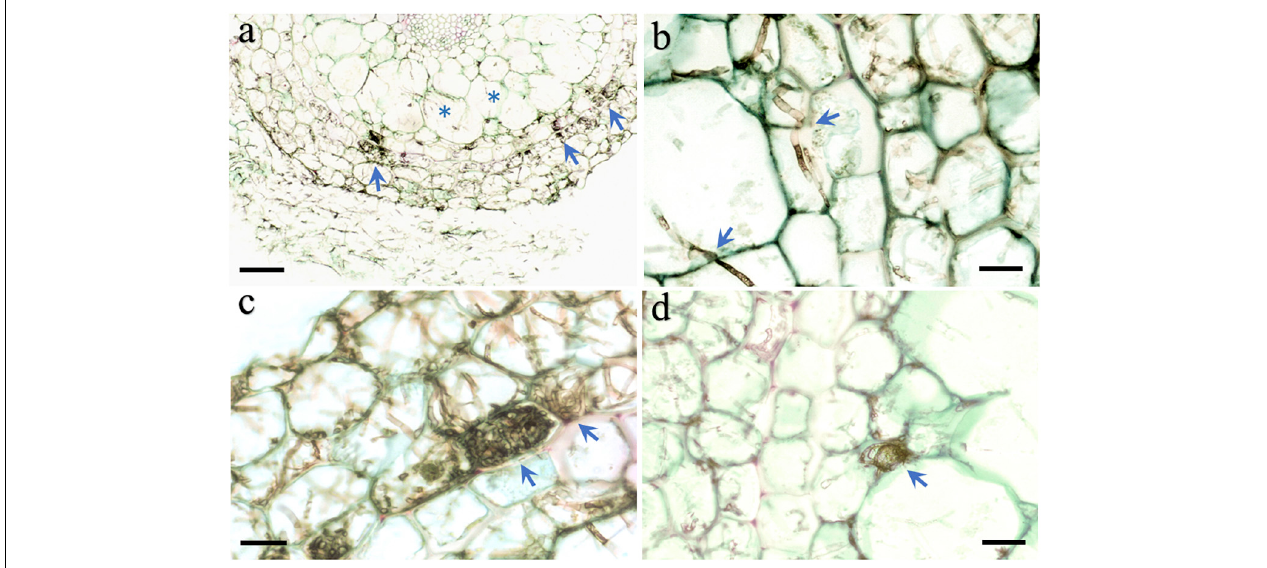
FIGURE 3 | Morphological characteristics of HB3-1 colonization in roots of Coelogyne viscosa seedlings. (A) The root surface is surrounded by intense hyphae and the hyphae invaded into velamen (arrow) and cortex (asterisk) cells. (B) Hypha in the velamen and cortex cells penetrate through cell wall and colonized neighbor cells (arrow), Septate in hyphae can be observed. (C) HB3-1 form peloton-like structures within the velamen cells (arrow). (D) Microsclerotium formed at the intercellular space (arrow). Scale bars: Panel (A) = 80 µ m; Panels (B–D) = 20 µ m.